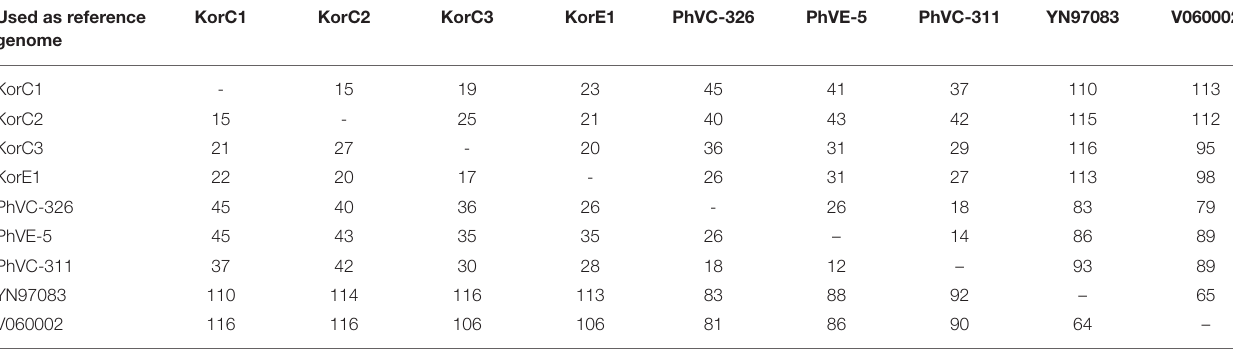
TABLE 2 | Pairwise nucleotide differences among strains belonging to the 2011 Philippines and 2016 Korea outbreaks. Used as reference